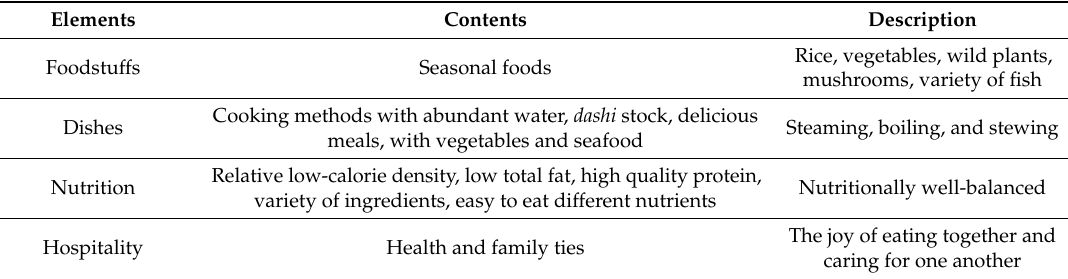
Table 2. Basic elements of the Japanese traditional diet 1 .